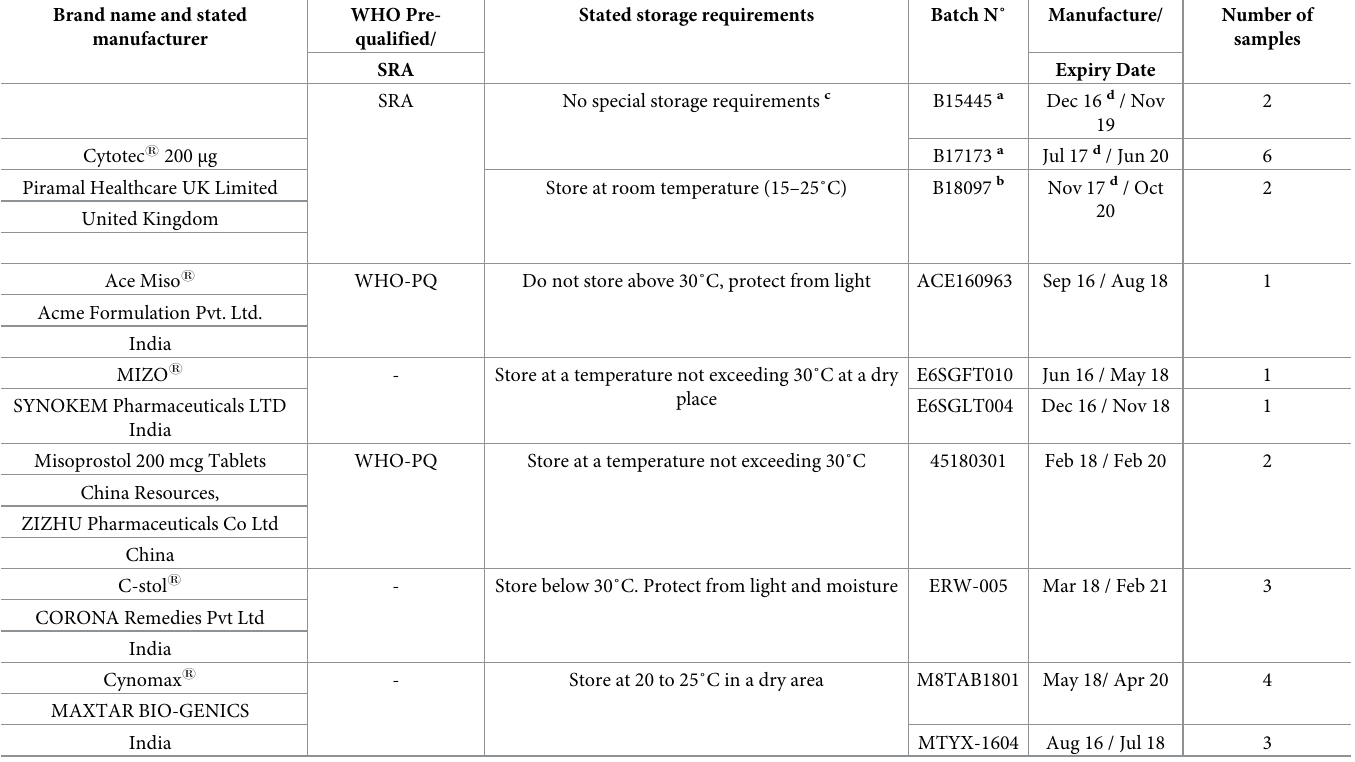
Table 3. List of misoprostol brands and batches collected in this